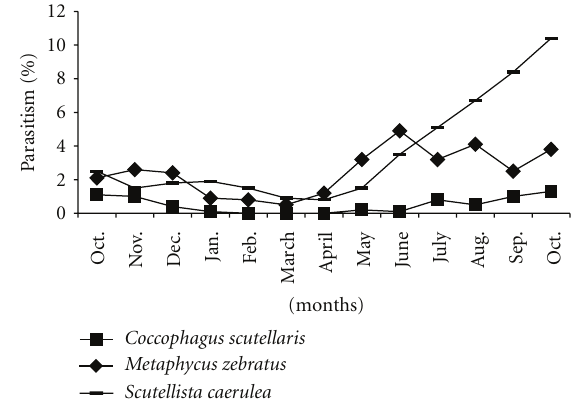
Figure 6: Percent parasitism of Coccophagus scutellaris and other associated parasitoid of Coccus hesperidum on guava in Giza governorate before releasing during